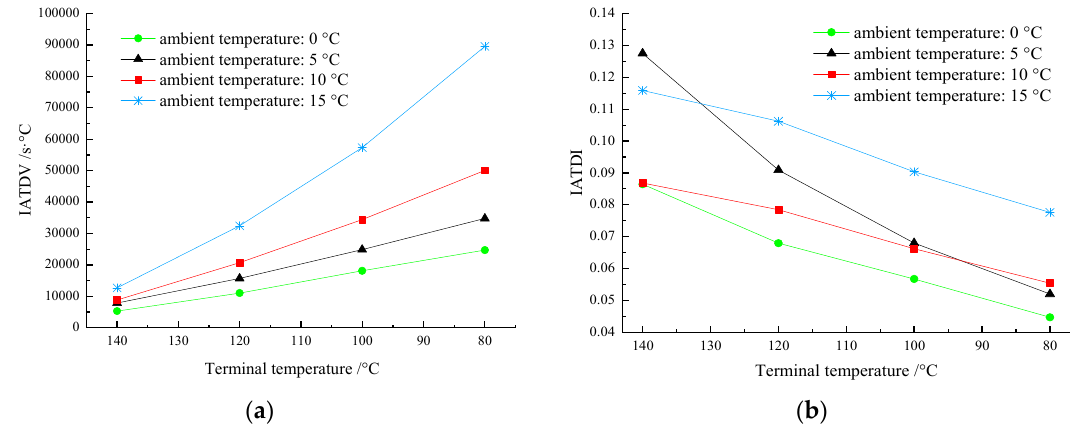
Figure 9. Two indices of the asphalt mixture mixed with PCTIA (AM-PCTIA) at different ambient temperatures: ( a ) IATDV; ( b ) IATDI.